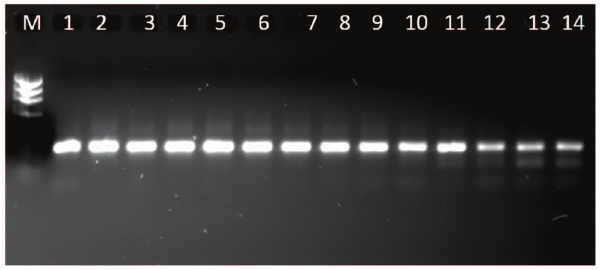
Figure 9. Bands of nifH gene from Pleurotus ostreatus mycelium. Numbers represent the order of the bands (see table 4). M 5 marker.